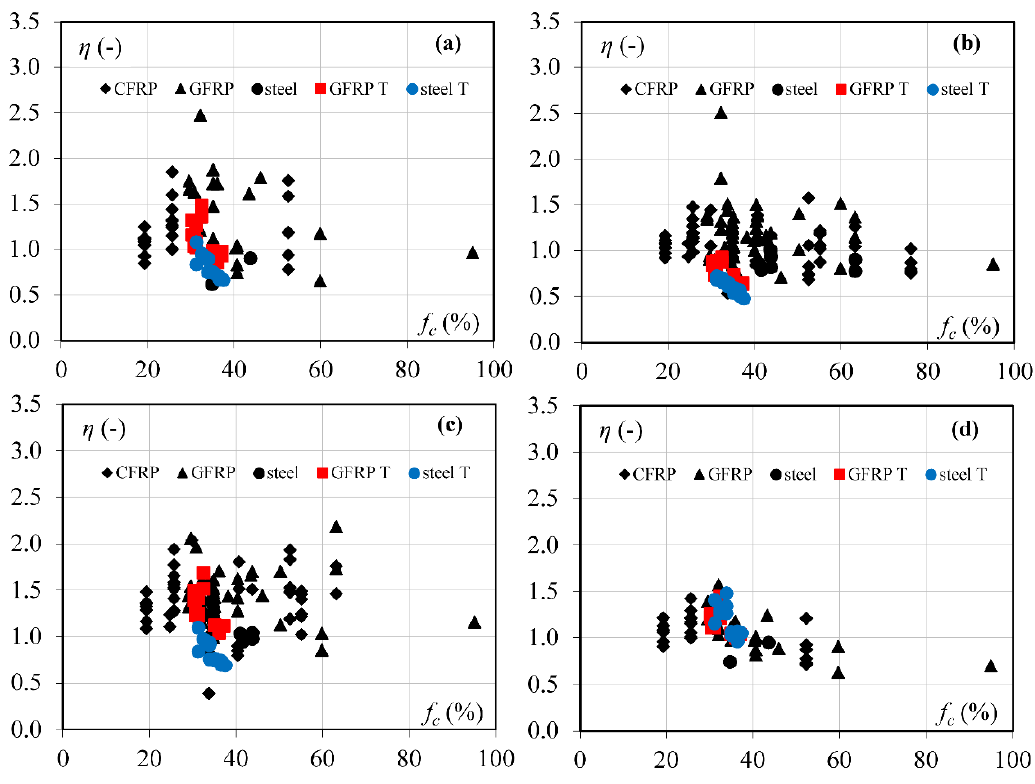
Figure 5. The influence of concrete compressive strength on η values: ( a ) Muttoni and Ruiz [11], ( b ) Zhang et al. [12], ( c ) Yang [13], ( d ) Cladera et al. [14].